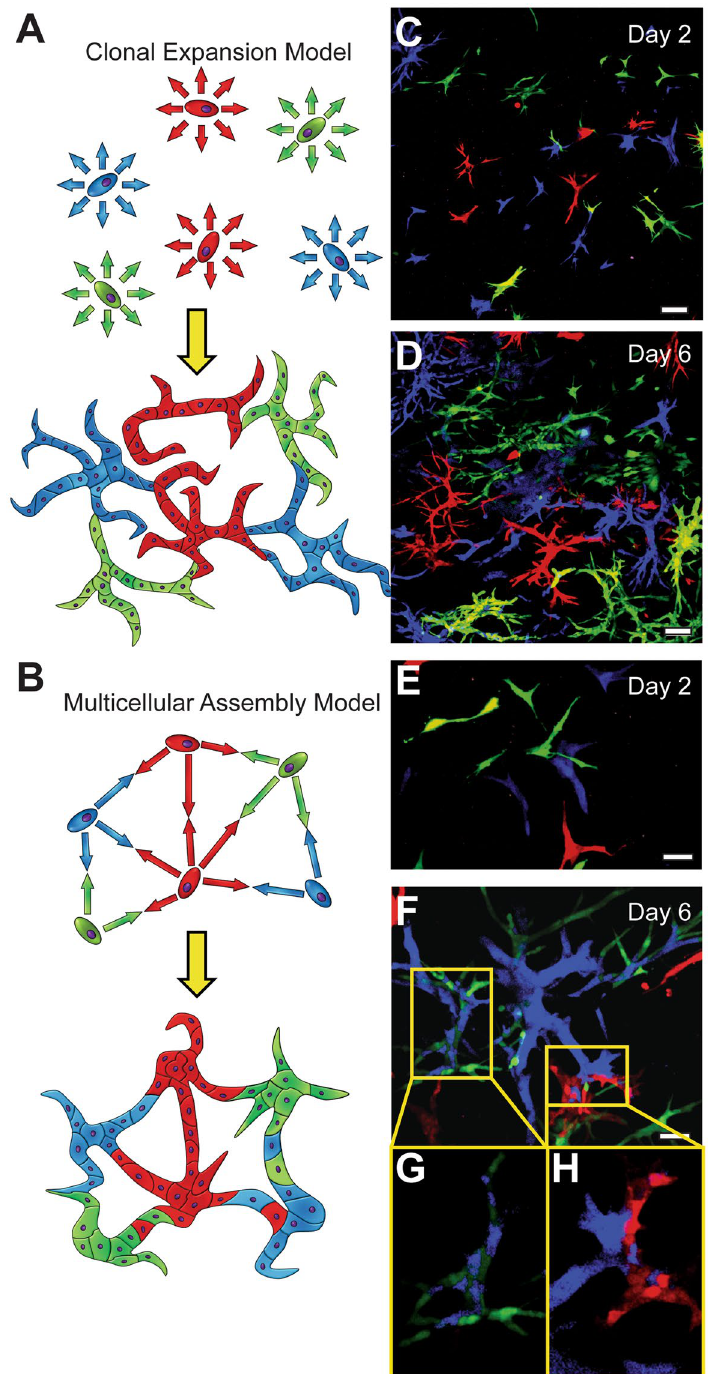
Figure 6. Ducts Branch Clonally, Assemble to Form Networks, or a Combination of Both. ( A ) Schematic of one proposed mechanism of duct formation wherein single cells give rise to clonal populations of branching structures composed of a single color. ( B ) Alternative proposed mechanism in which multiple cells assemble to form ducts with mixed lineages wherein resulting structures display a confetti or mosaic appearance. ( C,D ) Low magnification maximum intensity Z projection image of Identical populations of cholangiocytes expressing 1 of 3 different colors (red/green/blue, mCherry/eGFP/Azurite) mixed within liver dECM gel after 2 ( C ) and 6 ( D ) days in culture. Structures superficially resemble model A . Higher magnification image at 2 ( E ) and 6 ( F ) days indicate mixing and multicellular assemble (model B ). Single Z slices ( G,H ) indicate the mosaic appearance is not an artifact of maximum intensity z projection. Scale bar C,D = 100 μ m, E,F = 50 μ